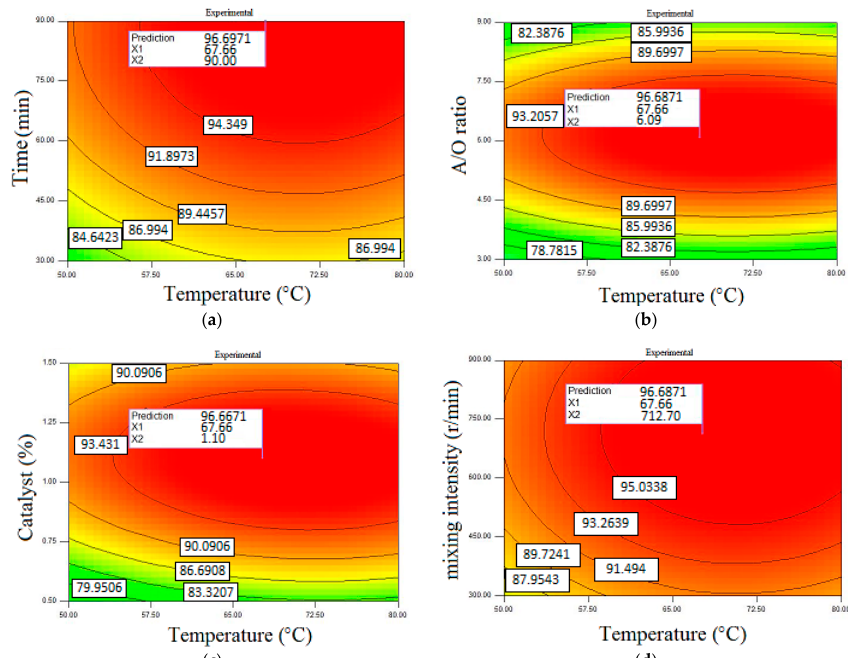
Energies 2018 , 11 , x 12 of 19 Figure 5. The optimization condition of methyl ester production in the case of importing experimental data. ( a ) Response surface based on time (min) and temperature (°C); ( b ) response surface based on A/O and temperature (°C); ( c ) response surface based on catalyst (wt. %) ratio and temperature (°C); and ( d ) response surface based on mixing intensity (r/min) and temperature (°C).